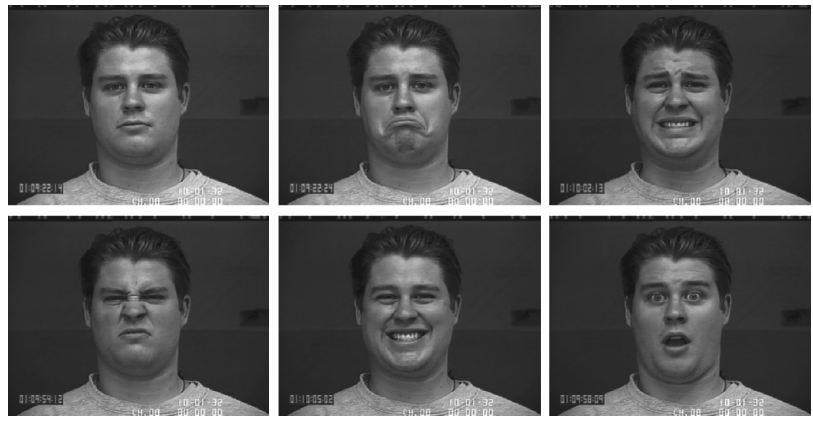
Figure 14. Cohn–Kanade Facial Expression Database (Subject 132 ©Jeffrey